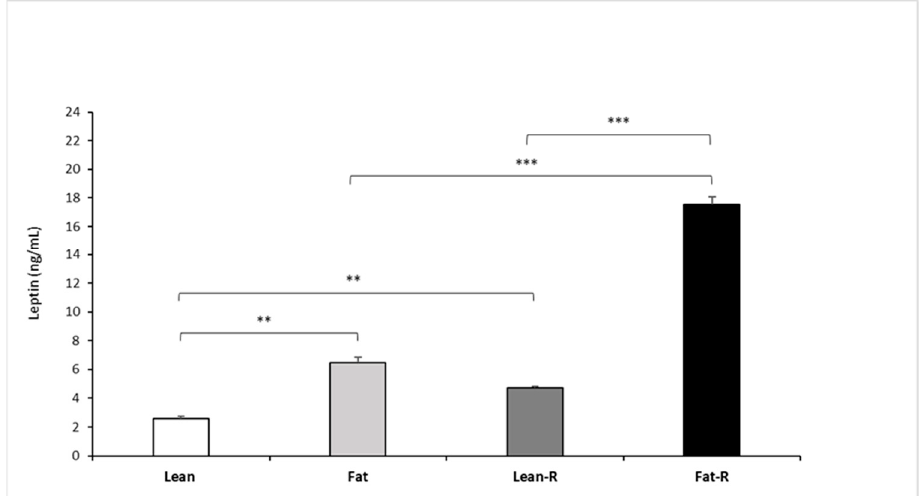
Figure 6. Plasma leptin concentrations. Mean concentrations of circulating ( ± SEM) of resistin in non-treated (Lean and Fat) animals and animals treated with recombinant bovine resistin (Lean-R and Fat-R) after 5 months of body weight alteration ( n = 5 per group). ** p < 0.01, *** p < 0.001 denote difference between groups.